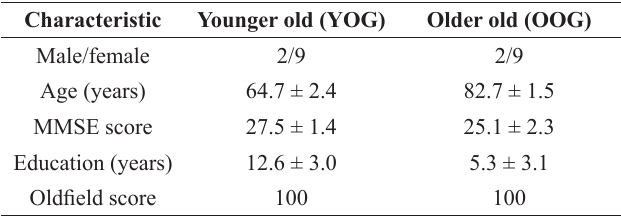
Table 1. Participants